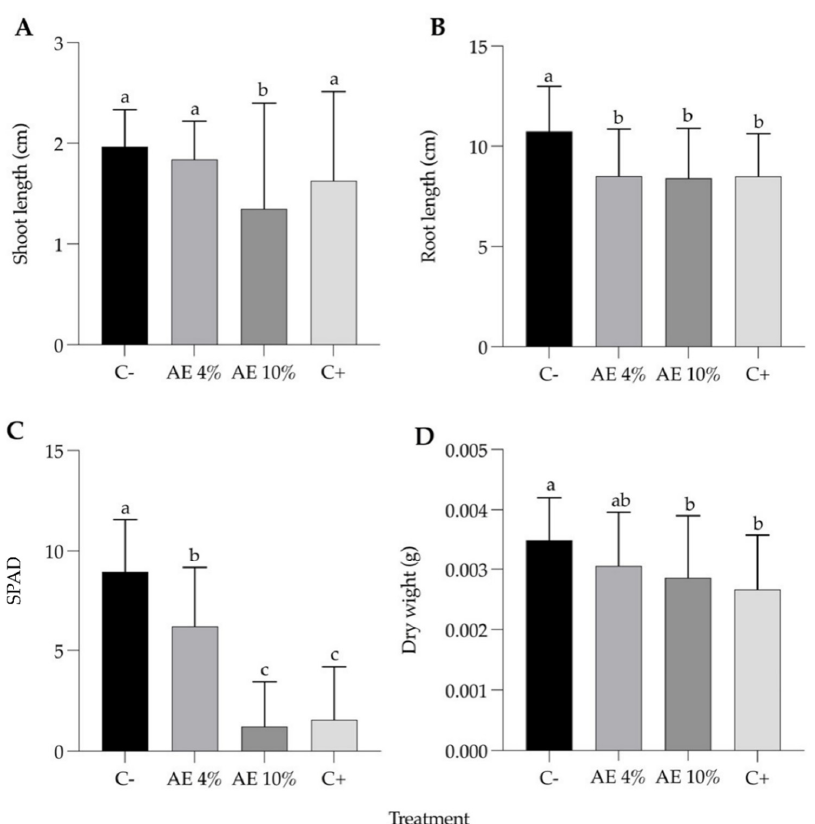
Figure 4. Post-emergence bioassay with lettuce. Parameters (7 days after treatment): ( A ) shoot length; ( B ) root length; ( C ) chlorophyll content (SPAD readings); and ( D ) seedling dry weight. Abbreviations: C- (distilled water), AE 4% (aqueous extract at 4%), AE 10% (aqueous extract at 10%), and C+ (NaCl). Bars represent the mean + SD. Different letters indicate significant differences by Kruskal–Wallis test and Dunn’s test ( p ≤ 0.05).